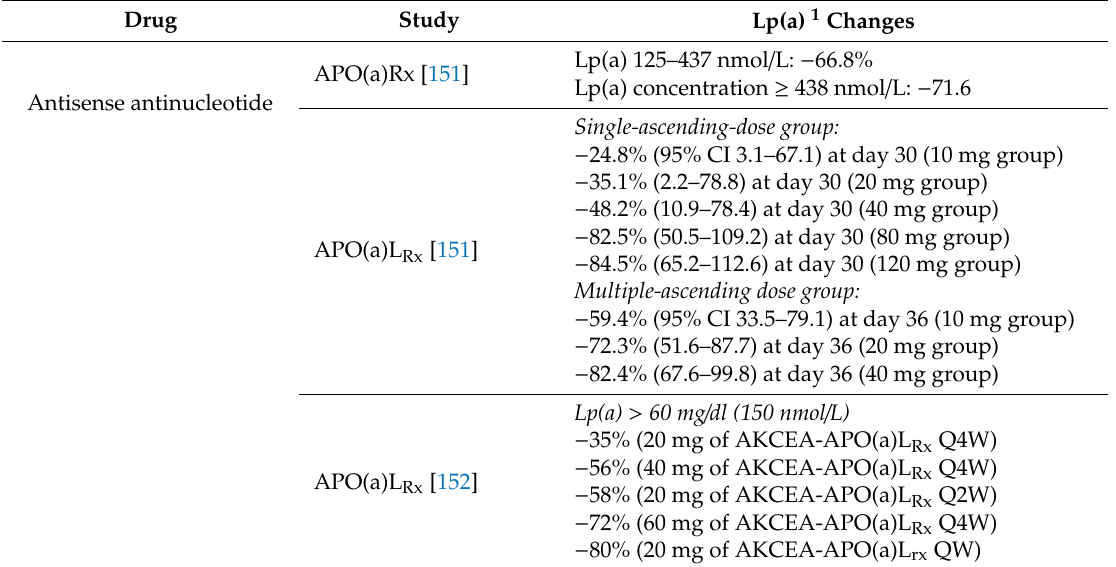
Table 4. Impact of antisense oligonucleotide APO(a) on lipoprotein(a) levels. Drug Study Lp(a) 1 Changes